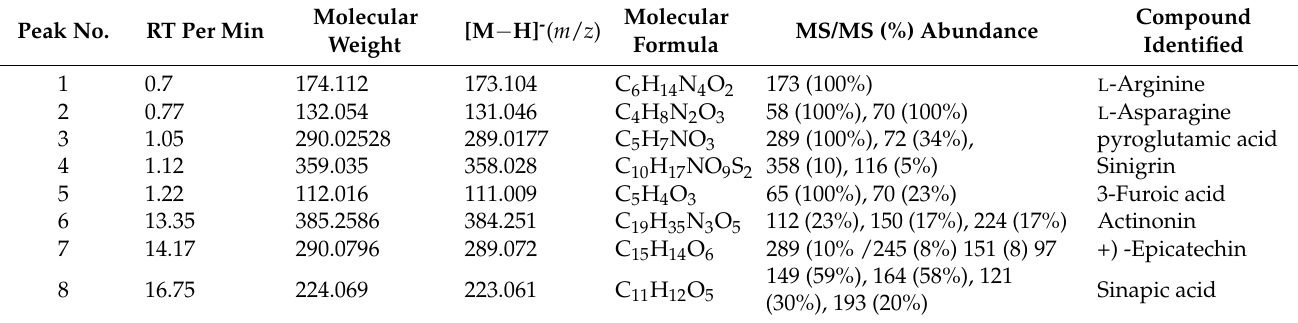
Table 6. Metabolites identified in the extracts of raw cabbage seeds using UHPLC-Q-TOF-MS2. RT, retention time. Peak